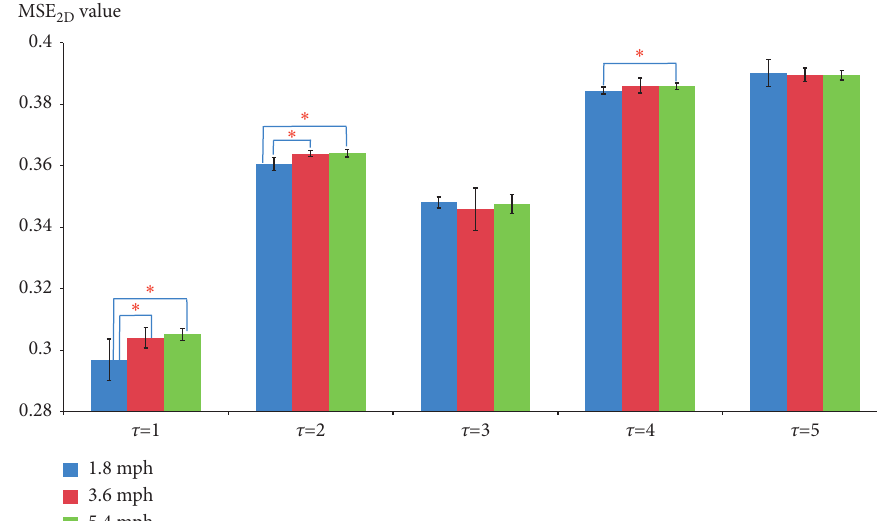
Figure 4: MSE 2D values of plantar pressure images from the time scales τ 5.4mph). ∗ indicates p < 0 . 05.